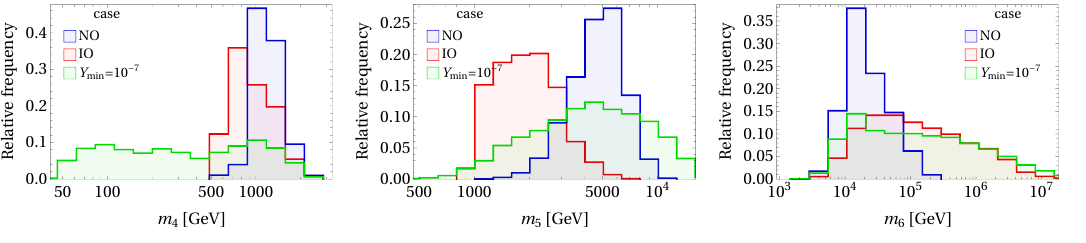
Figure 11 . Histograms of the heavy-neutrino masses for the three